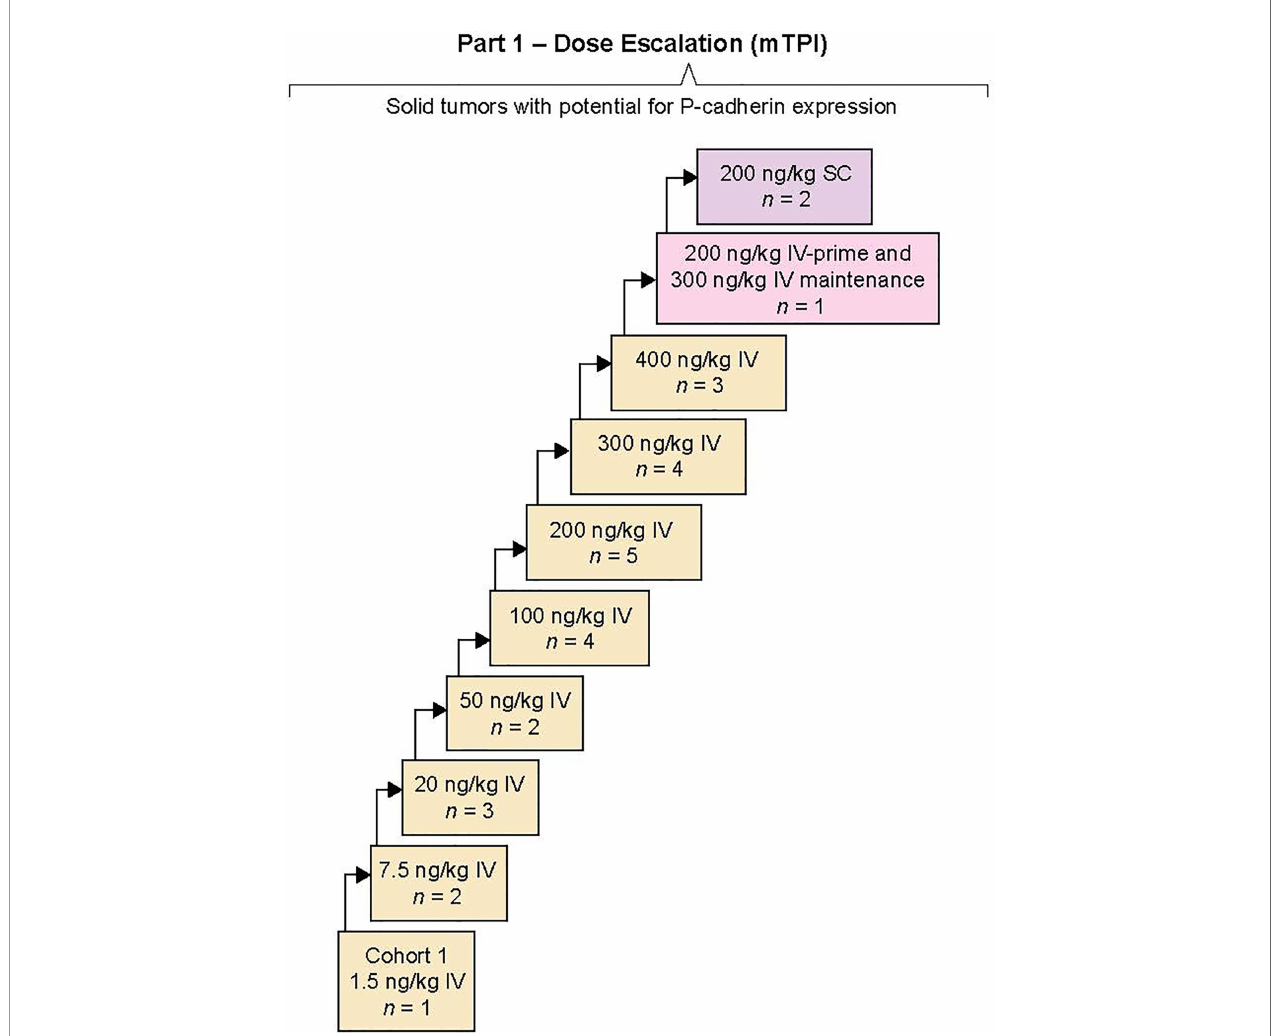
FIGURE 1 | Study design. A fi rst-in-human, open-label, multicenter, phase 1 study of PF-00671008 in advanced solid tumors. The primary objective of part 1 of the study was to determine the maximum tolerated dose and the recommended phase 2 dose. Sequential dose escalation was completed by a modi fi ed toxicity probability interval design evaluating intravenous (IV) and subcutaneous (SC) routes. Part 2 was not